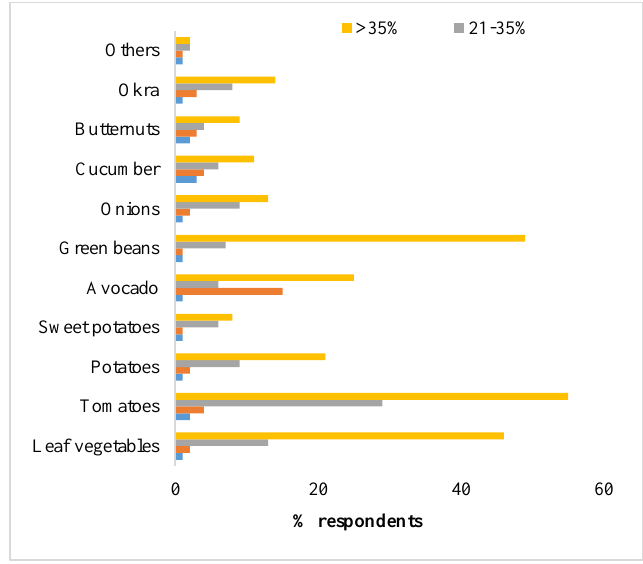
Figure 2. The proportion of spoiled crop produce during the COVID-19 lockdown, expressed as the percentage of respondents (n=300).